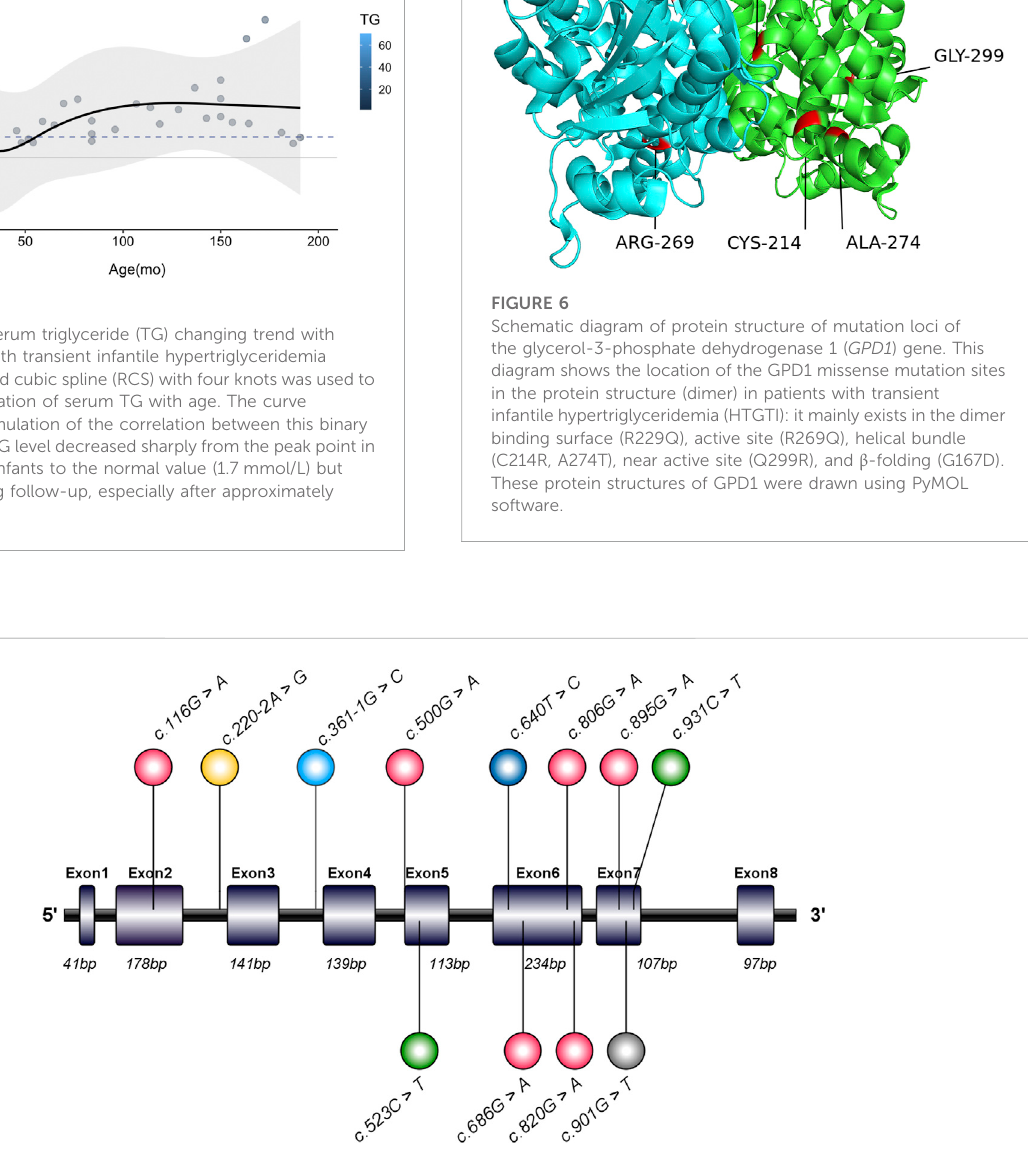
FIGURE 5 Schematic diagram and mutation sites of glycerol-3-phosphate dehydrogenase 1 ( GPD1 ) gene in transient infantile hypertriglyceridemia (HTGTI) patients. The human GPD1 contains eight exons and encodes a protein consisting of 349 amino acid residues. This image illustrates the spectrum of GPD1 mutation sites associated with HTGTI from the reported cases, marked in the lollipop style, including 10 mutation sites on exons and 2 on introns. This spectrum was generated using illustrator for biological sequences (IBS).